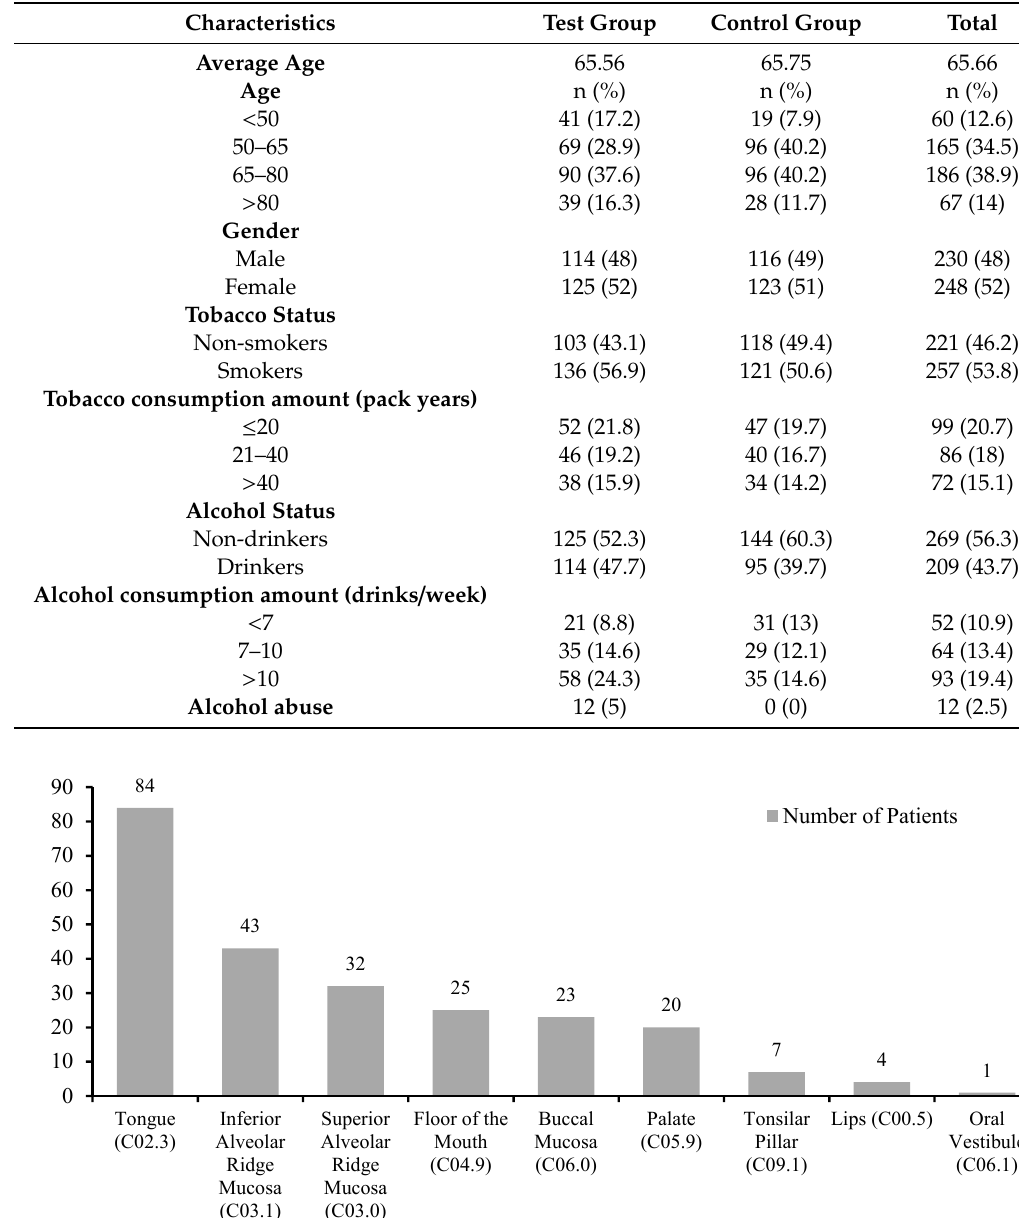
Table 1. Patients’ preview and characteristics.